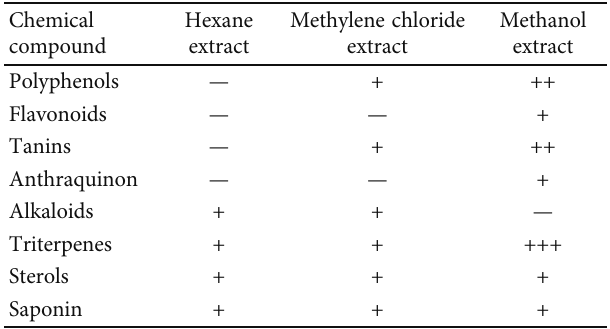
Table 4: Phytochemical qualities of the crude extract of Indigofera tinctoria